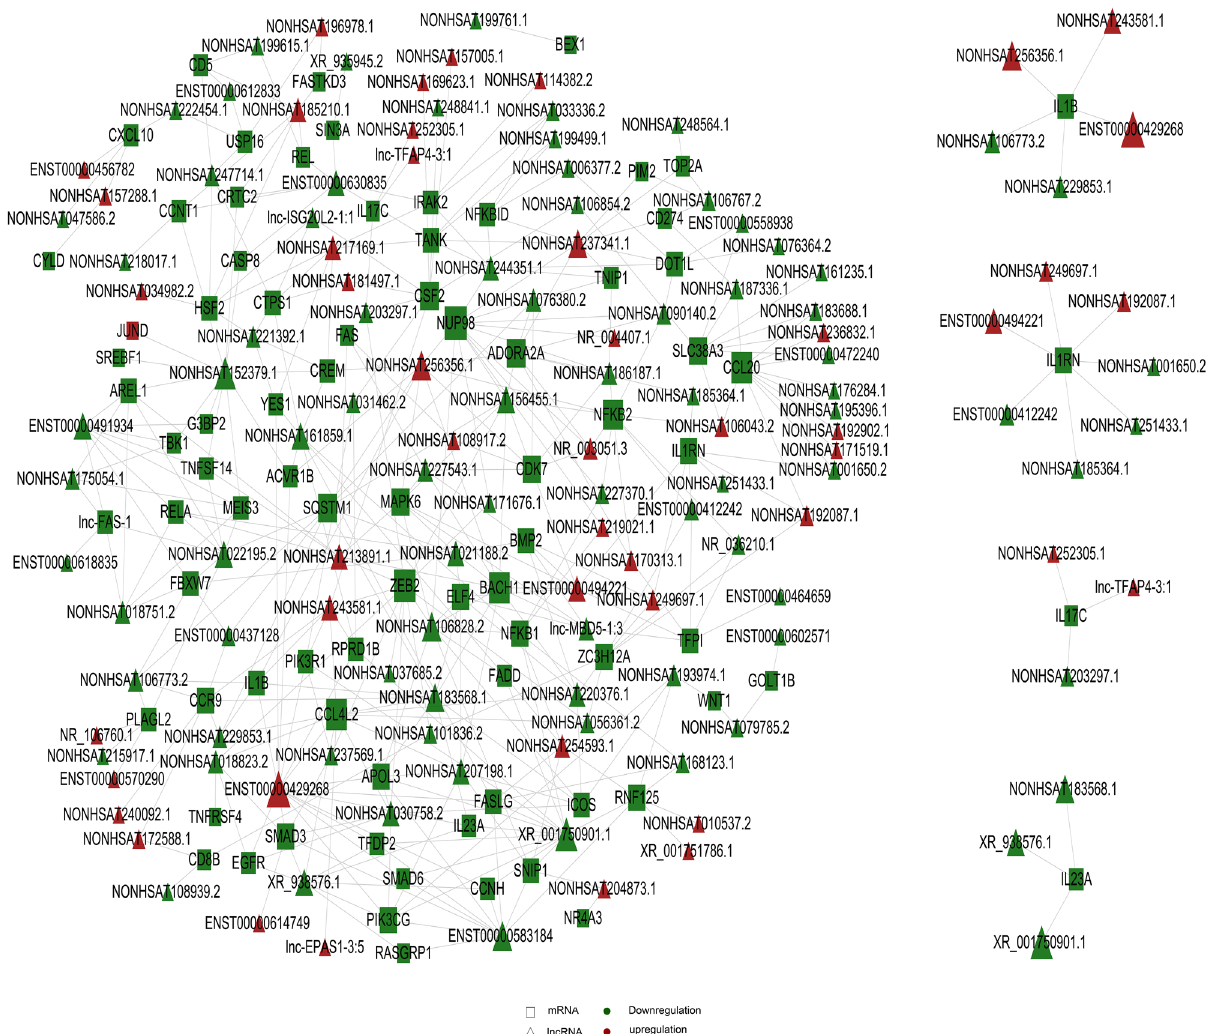
Figure 6. lncRNA co-expression network diagram. Triangle represents lncRNA, square represents mRNA; red represents up-regulation and green represents down-regulation. Each dot in the network represents a gene, and the size of the circle represents the gene’s ability to interact with other genes. We use degree to quantify it, and the larger the degree, the more genes interact with other genes. Based on the degree of each gene in the gene synergy network, key genes in the network can be obtained. Samples are from 3 recurrent COVID-19 patients and 3 healthy